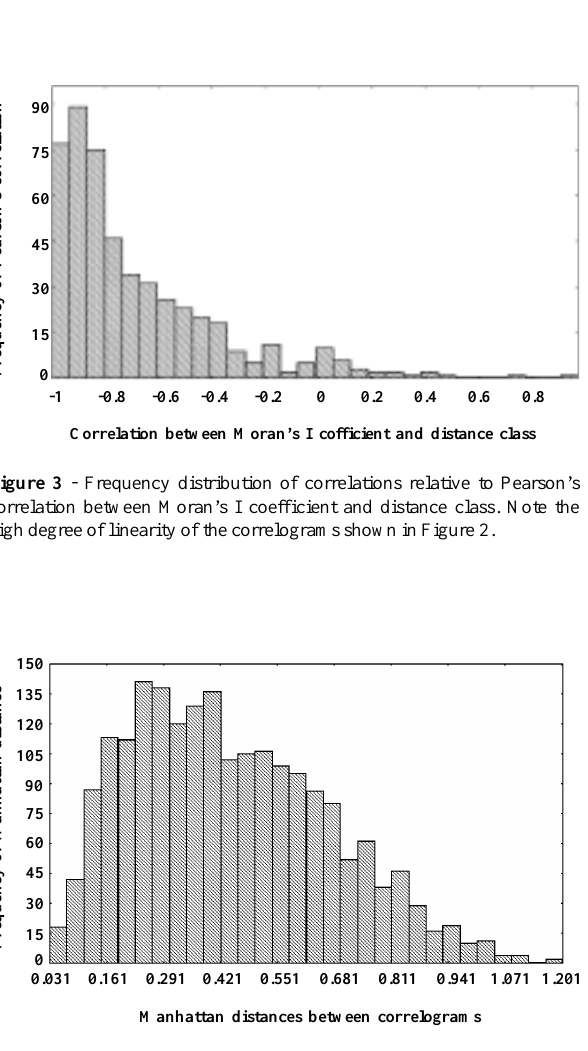
Figure 4 - Frequency distribution of pairwise Manhattan distances be- tween correlograms generated using the Ornstein-Uhlenbeck stochastic spatial process with the same